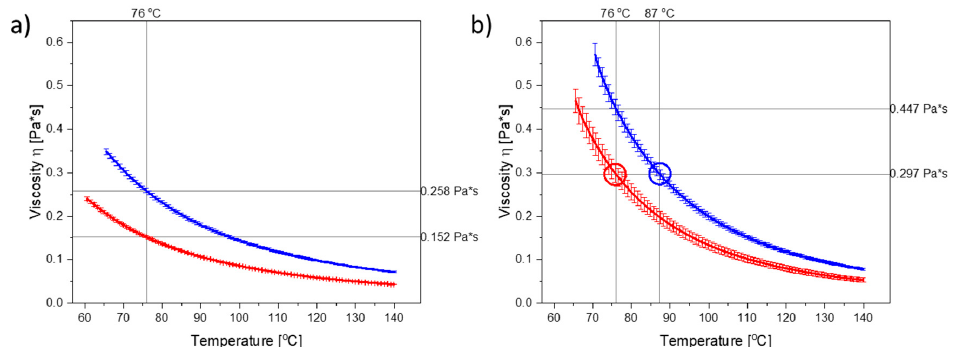
Figure 1. Temperature-dependent viscograms obtained at a shear rate of 100 s − 1 for ( a ) PEG 3000 (red) and PEG 4000 (blue) and ( b ) PEG 3000 with 30 wt% CCX (red) and PEG 4000 with 30 wt% CCX (blue). Reference lines indicate the temperatures and viscosities used in this study. Mean ± SD ( n = 3).